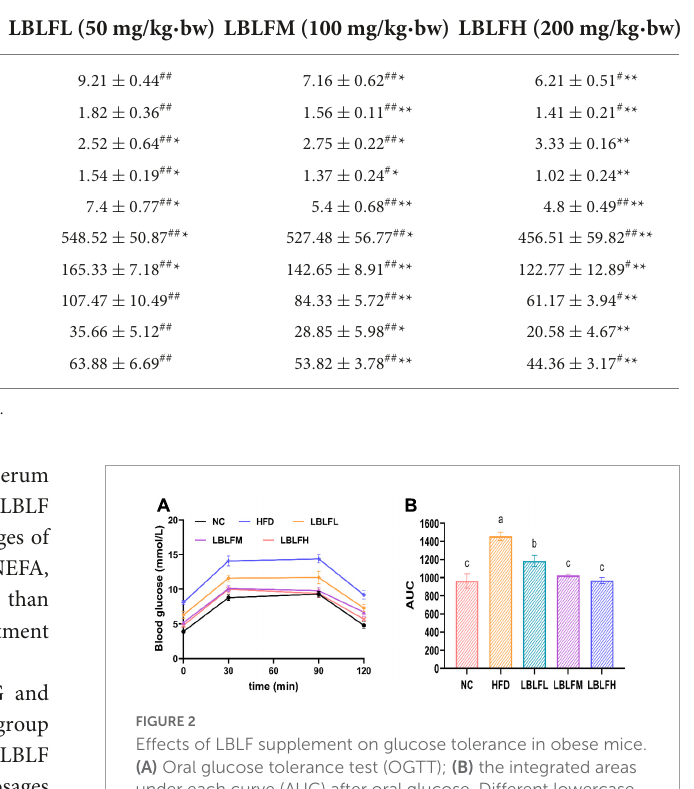
LBLF suppresses hepatic and serous oxidative stress in obese